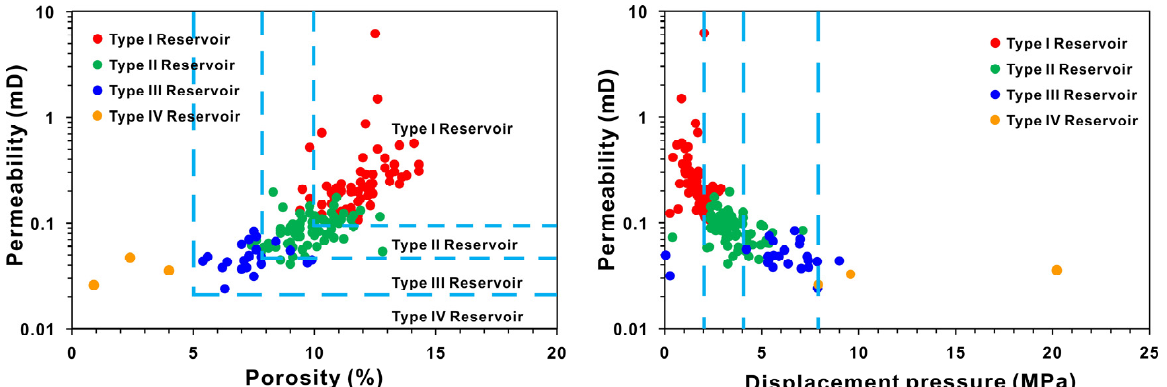
Figure 9. Boundaries of permeability, porosity, and displacement pressure of different types of reservoirs.